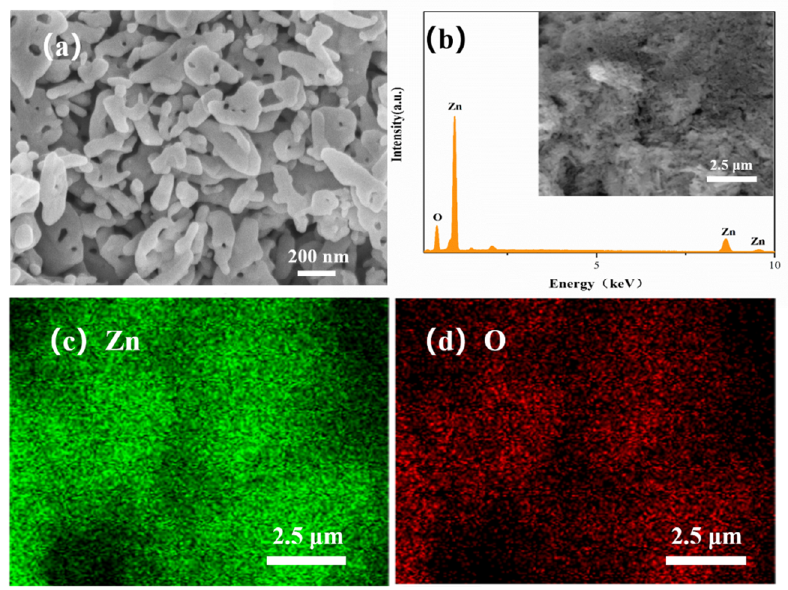
Figure 4. SEM scan ( a ) of ZnO NPs, EDS energy spectrum ( b ) and distribution of Zn ( c ), O ( d ) in surface scan image.